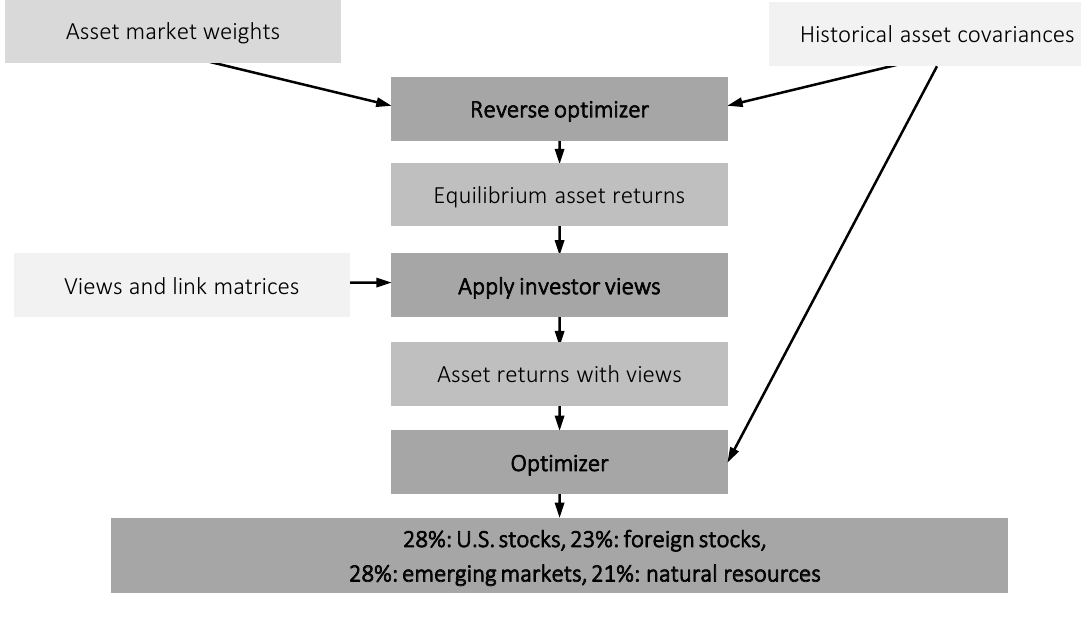
Figure 1. Optimization